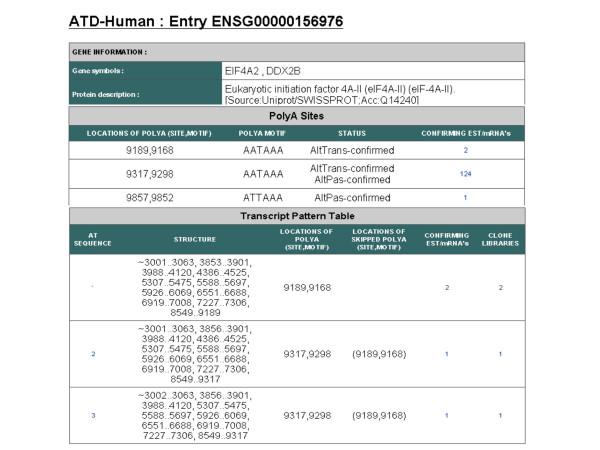
Examples of PolyA table and transcript pattern table. Locations of the polyA site and signal are as on the gene. Status of the polyA site refers to whether the site is identified by the AltTrans or AltPAS pipeline. Entry in the last column is hyperlinked to pages listing detailed information on the confirming transcript sequences.